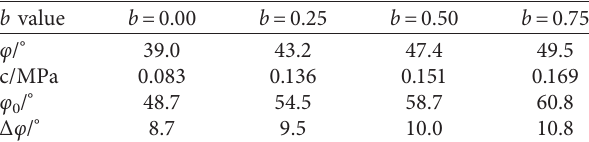
Figure 13: Linear strength envelopes of the coarse granular material at different b values: (a) b � 0.0; (b) b � 0.25; (c) b � 0.50; (d) b � 0.75. Table 3: Strength parameters at different b